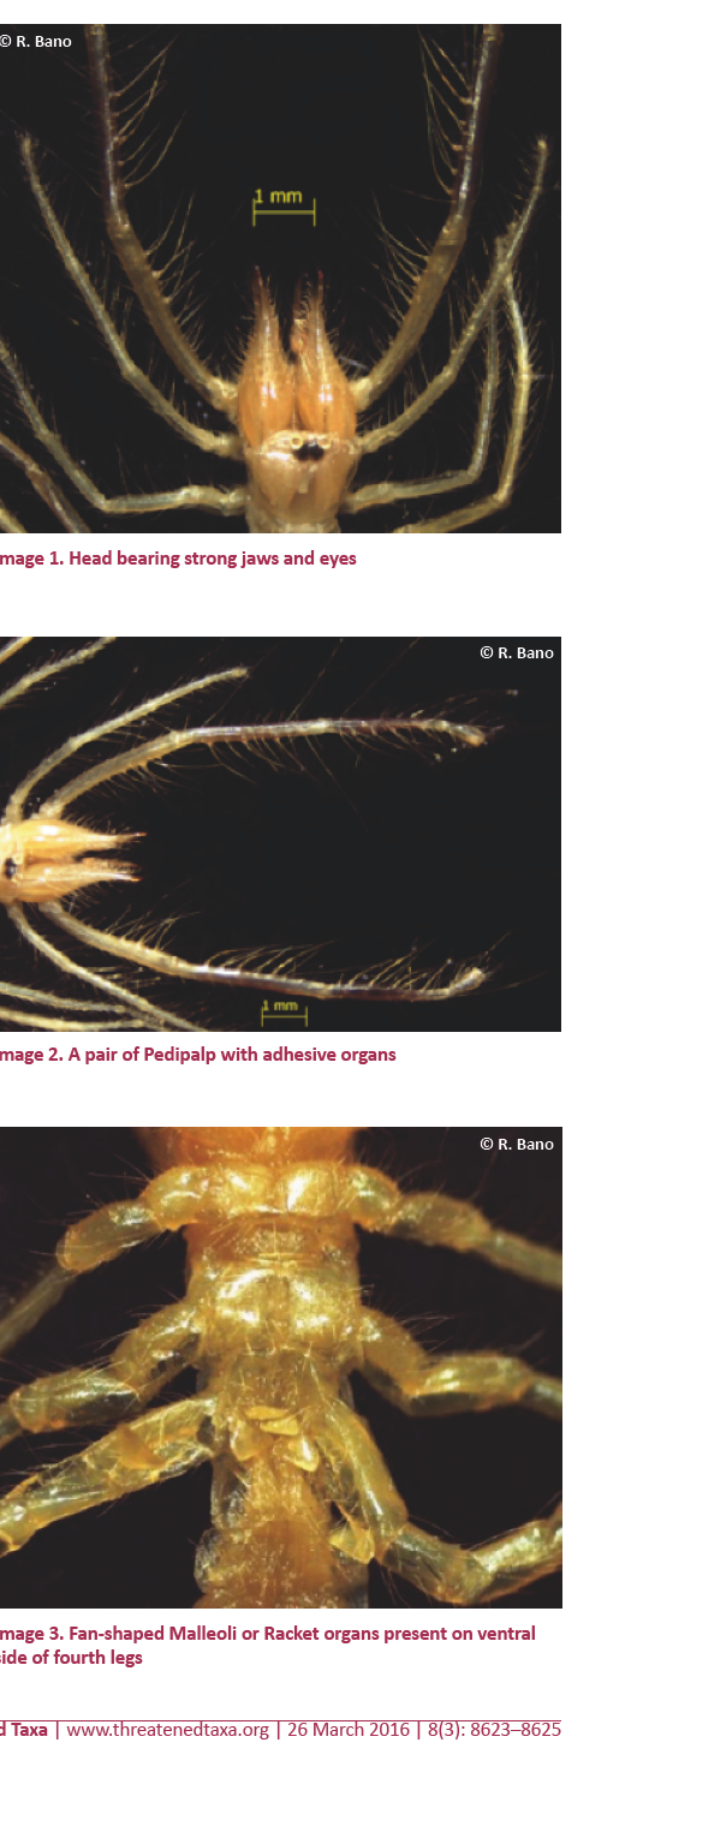
Image 3. Fan-shaped Malleolfi or Rackett organs presentt on venttral sfide of fourtth